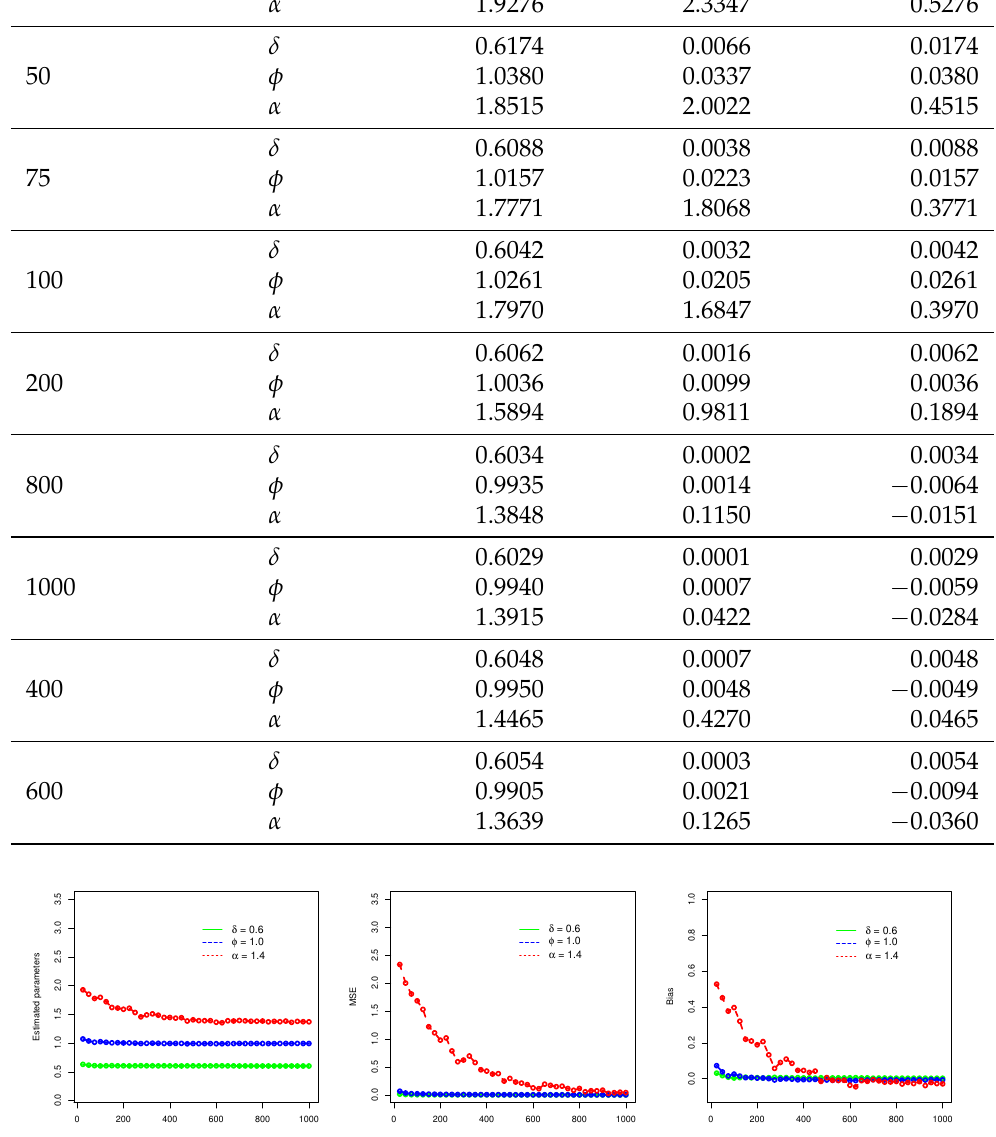
Figure 7. The visual illustration of the SS of the NACos-Weibull distribution for δ = 0.6, φ = 1.0, and α =